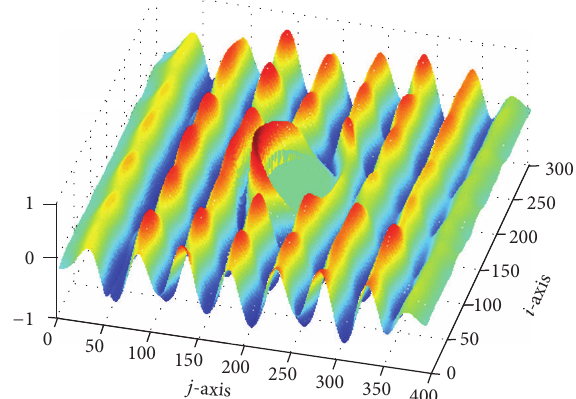
Figure 5: Three-dimensional field distribution plot for a 545 THz sine wave with a steady lossless cylindrical cloak in its path and appropriately scaled parameters.